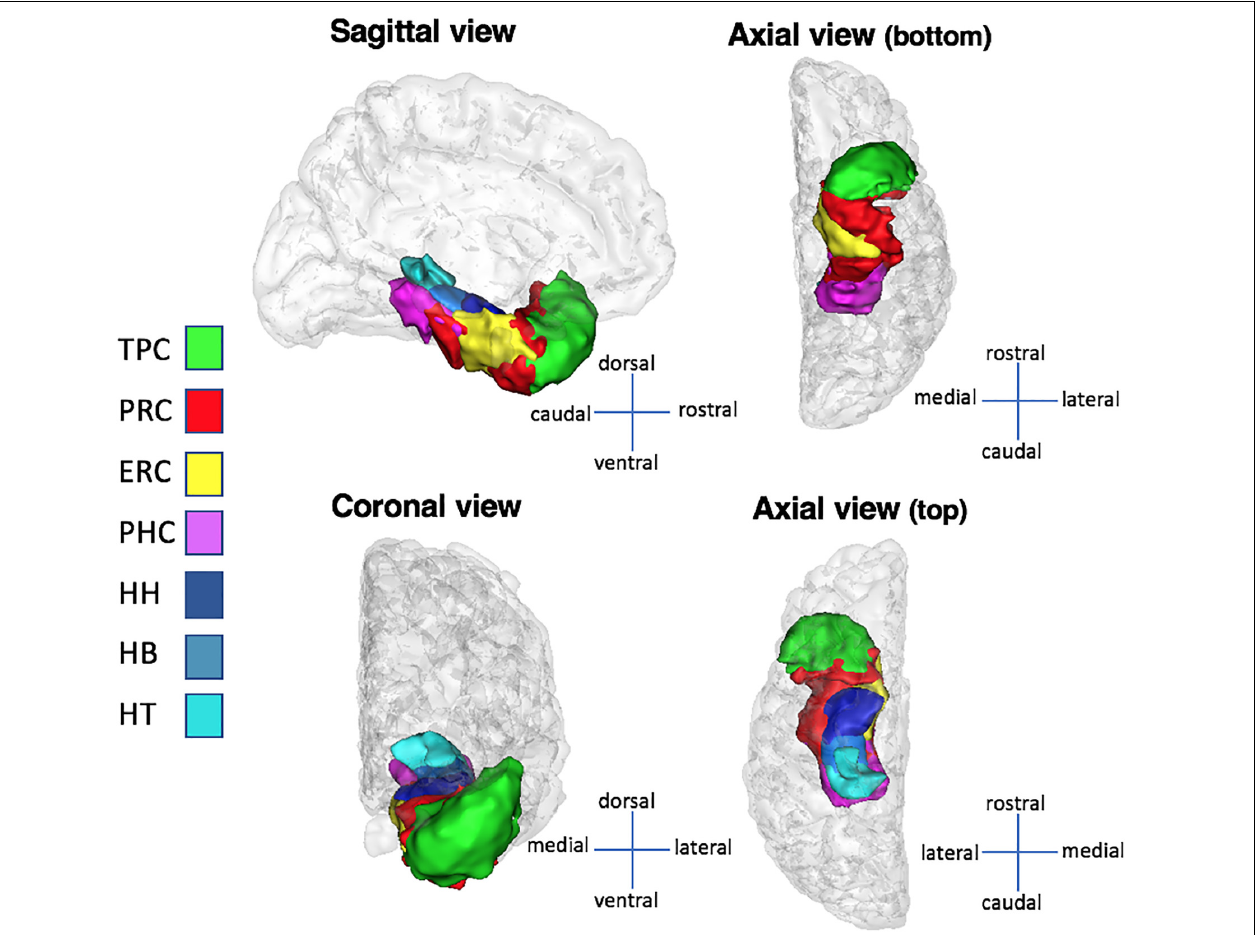
FIGURE 2 | Medial temporal lobe structures in sagittal, coronal, and axial views. The structures presented here are computed over the whole population and converted to surfaces with BrainVisa’s AimsMesh function. A threshold of 5% (the same used volumes visualization) was applied on the surfaces to keep voxels present in at least 95% of subjects. Abbreviations: TPC, temporopolar cortex; ERC, entorhinal cortex; PRC, perirhinal cortex; PHC, parahippocampal cortex; HH, hippocampus head; HB, hippocampus body; HT, hippocampus tail.